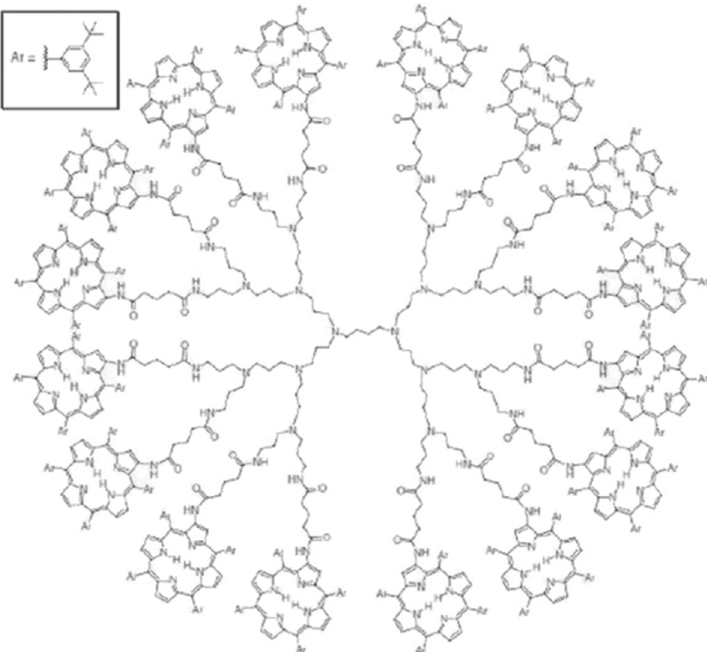
Figure 6: Porphyrin dendrimer D Table 3: Edge partitioning based on degree of D